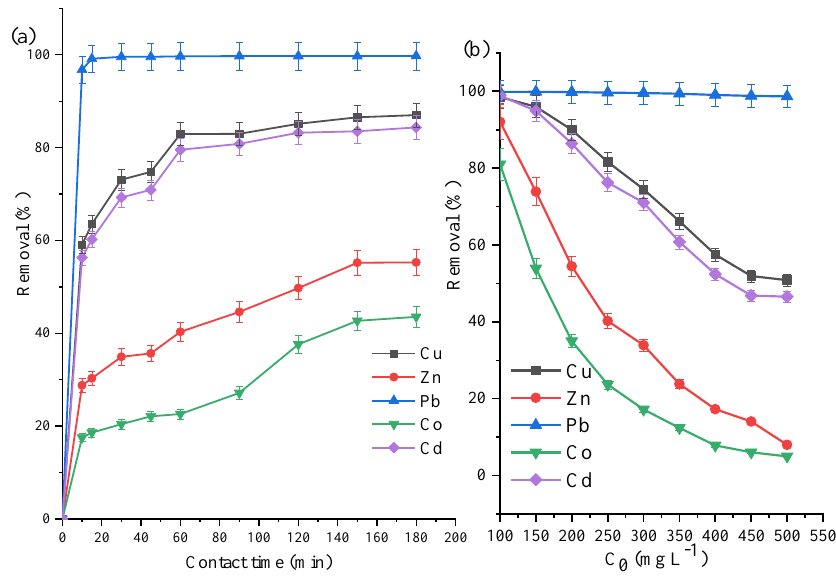
Figure 6. FAU from VK (ZVK-FAU) simultaneous removal of five metals at ( a ) 300 mg L − 1 from 0 to 180 min and ( b ) 90 min for C 0 = 100 to 500 mg L − 1 and 5 g L − 1 zeolite loading.